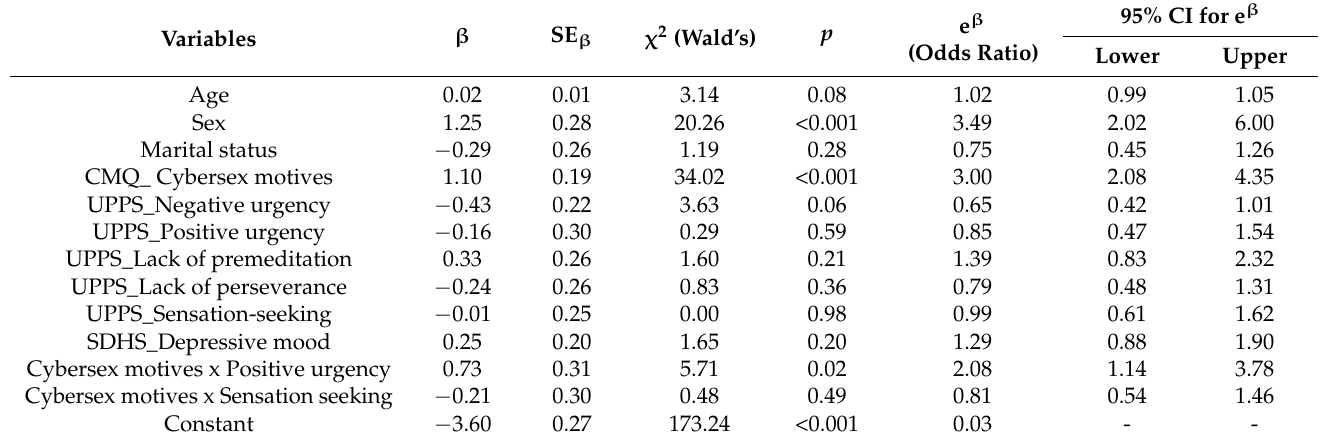
Table 2. Binary logistic regression analysis on 1159 Tinder payers vs.